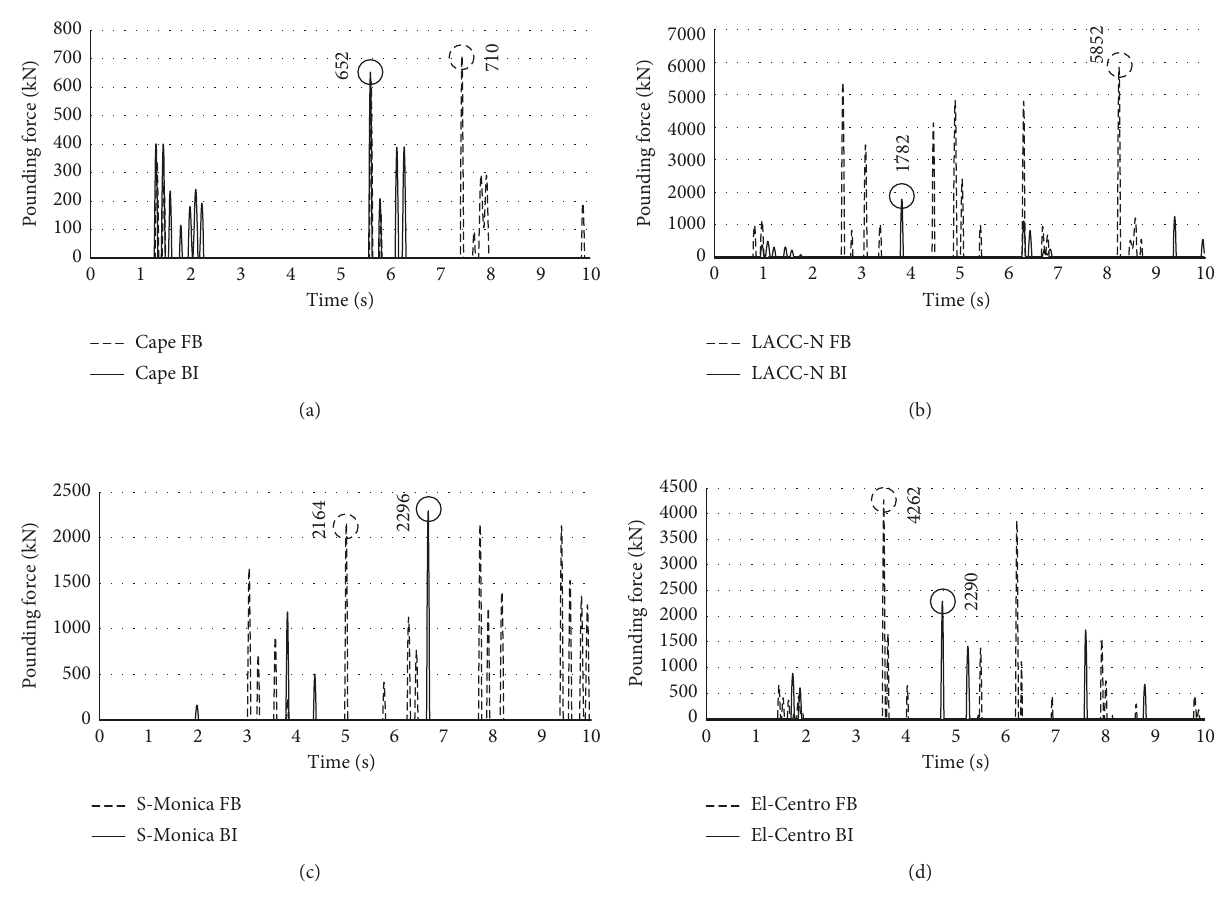
Figure 11: Pounding force at the pounding level of FFB and FBI adjacent buildings. (a) Cape. (b) LACC-N. (c) S-Monica. (d)